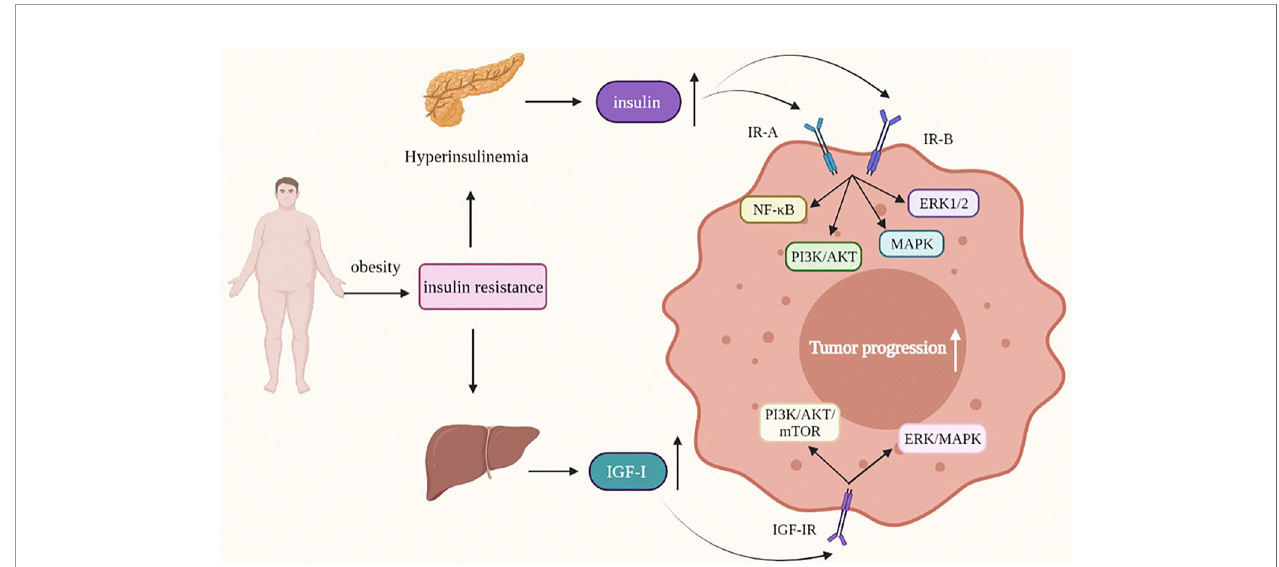
FIGURE 3 | Insulin and IGF-I modify the behavior of obesity-related tumor cells. IGF-I, Insulin-like growth factor-I; MAPK/ERK, mitogen-activated protein kinase/ extractor signal regulated kinase; PI3K/AKT, phosphoinositide-3 kinase/protein kinase